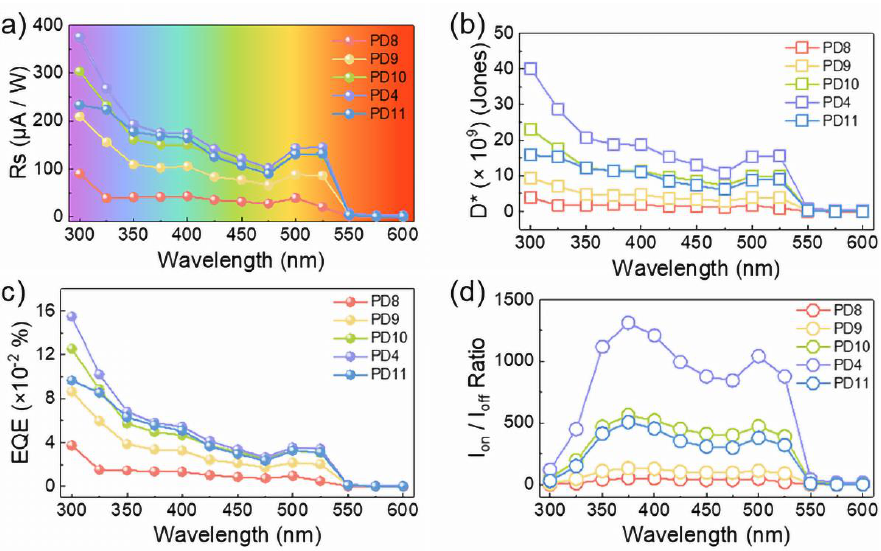
Figure 7. The spectrum dependent ( a ) responsivity (R s ), ( b ) normalized detectivity (D*), ( c ) external quantum efficiency (EQE), ( d ) I on /I off ratio plots with different annealing Table 3. Comparison of the photodetector performance created from different perovskite materi- als.